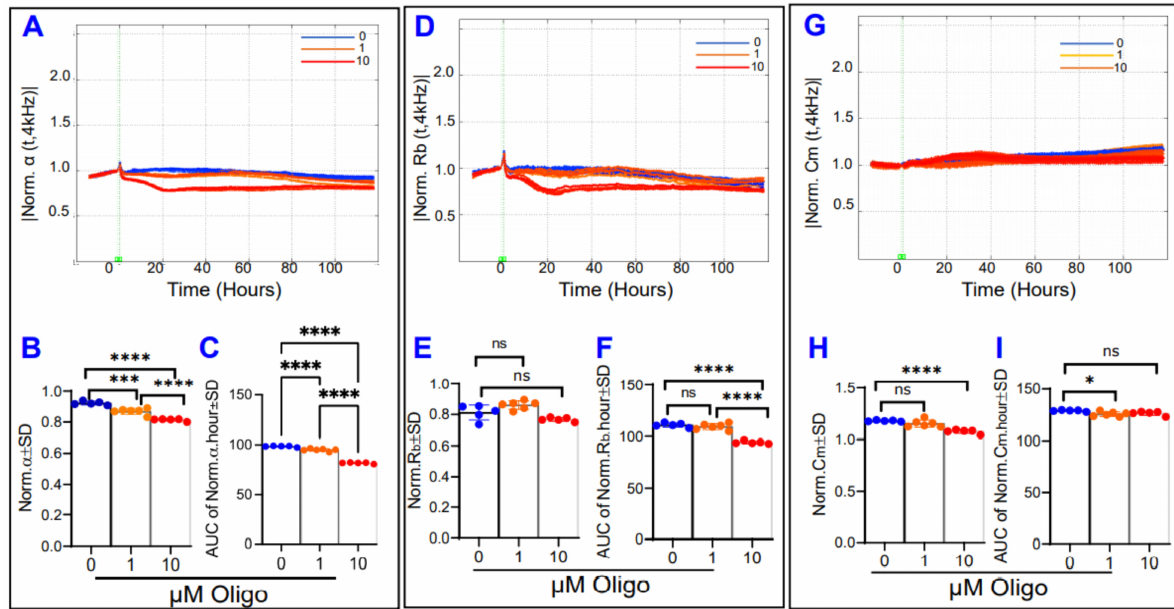
Figure 9. Real-time measurement of α , R b , and C m in ARPE-19 cells in a state of ATP synthase inhibition. ( A ) Normalized α measured at 4000 Hz vs. time (T) from the start of treatment at T = 0 to 100 h after initiation of treatment with an oligomycin concentration of 0, 1, or 10 µ M. ( B ) α values at the experimental end T = 100 h, both oligomycin (Oligo) groups demonstrate differences from control (Oligo 0). ( C ) Areas under the curve (AUC) of normalized α for the time from treatment start to experiment end. By the end of the experiment, ATP synthase inhibition has resulted in significant reductions to α in a dose-dependent fashion. ( D ) Normalized R b measured at 4000 Hz vs. time (T) for the interval from the start of treatment at T = 0 to 100 h after initiation of treatment. R b values at T = 100 h, where the 10 µ M but not the 1 µ M Oligo group had an effect. ( E ) R b values at the experimental end T = 100 h, both Oligo groups demonstrate no differences from control. ( F ) AUC of normalized R b for the time T = 0–100 h. Oligomycin treatment results in a reduction in R b at high doses, and there is no significant change to R b at low doses. ( G ) Normalized C m measured at 4000 Hz vs. time (T). ( H ) C m values measured at T = 100 h, where only the high dose oligomycin had an effect on endpoint C m . ( I ) AUC of normalized C m for treatment interval. The behavior of the oligomycin 1 µ M group throughout the entire experiment time was slightly different from control (Oligo 0), while the behavior of the 10 µ M Oligo group did not differ over this time frame. Abbreviations: Norm, normalized; AUC, area under the curve; ns, no significance. Data shown are the mean ± SD of 5–6 independent biological replicates per group. p values are * p ≤ 0.05, *** p ≤ 0.001, and **** p ≤